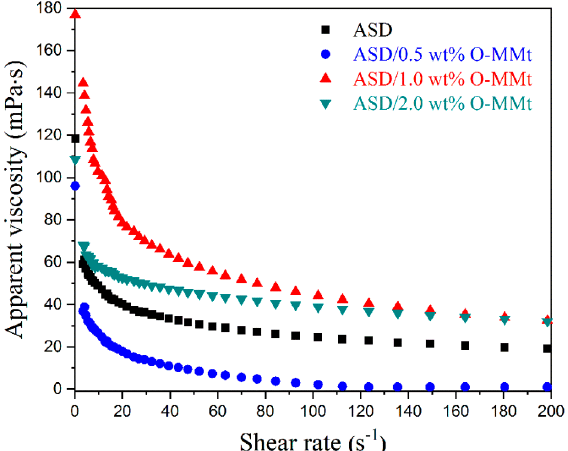
Figure 14. Effect of shear rate on the apparent viscosities of the nanocomposites (5 g/L) at 25 ℃ .